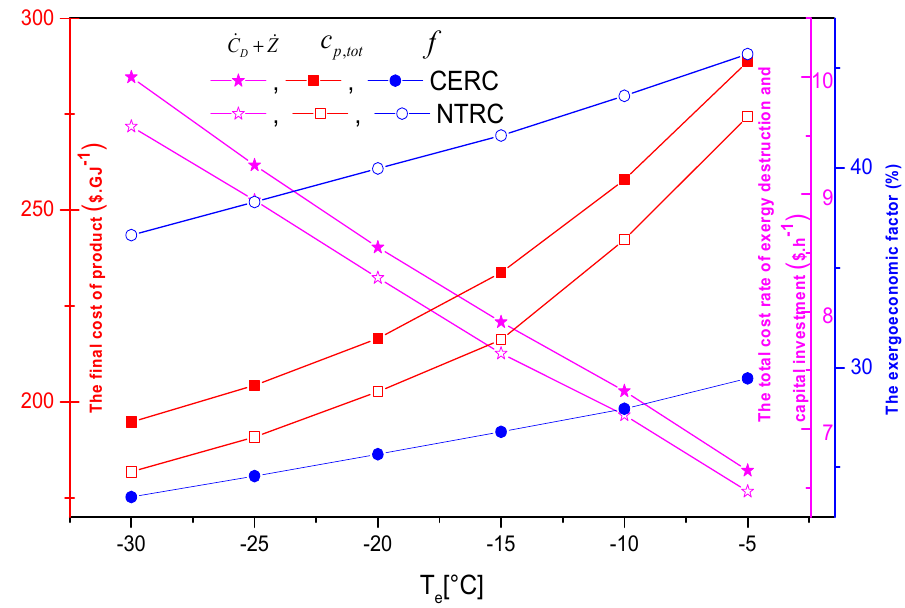
Figure 13. The e ff ect of T e on the exergoeconomic factor, the final cost of the product c p , tot , and overall . . Figure 13. The effect of T e on the exergoeconomic factor, the final cost of the product (cid:1855) (cid:3043),(cid:3047)(cid:3042)(cid:3047) , and overall Z + C D (cid:1852)(cid:4662) + (cid:1829)(cid:4662) (cid:3005) .